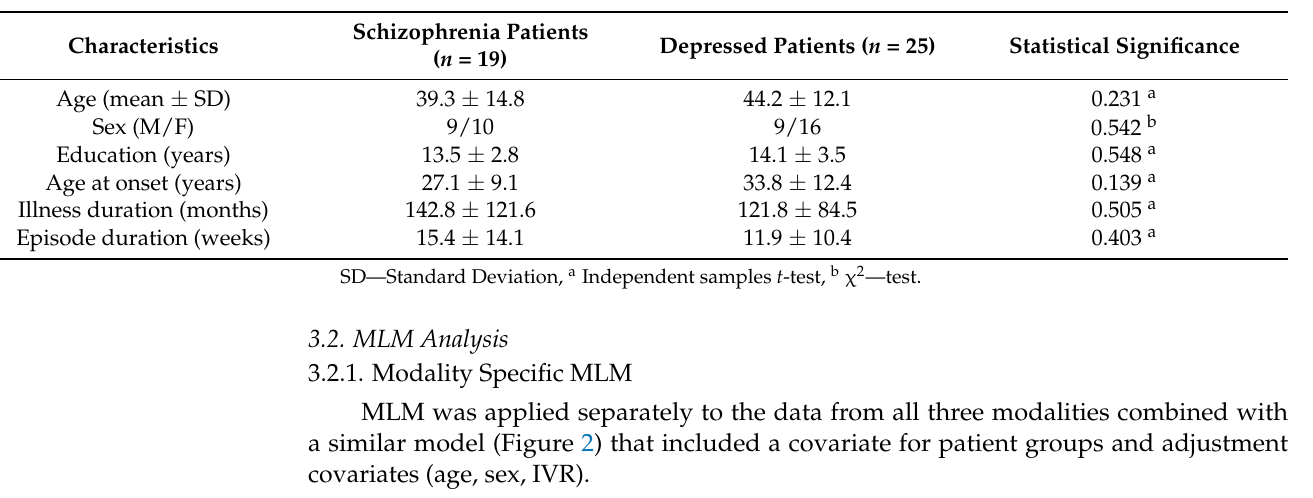
Figure 2. MLM components and subjects score for each of the modality. The first subjects, to the left (x-axis = N of subjects) correspond to the schizophrenia group and the rest to the depression group. The blue lines correspond to the calculated empirical components and the red dashed lines correspond to its projections/prediction in the space defined by the condition of interest, i.e., the differences between the two diagnostic groups. First segment of the figure shows the specific com- ponents identified using the resting state fMRI data, second segment shows the eigen-components which best summarize the fMRI task-related data; last segment shows the specific components for the anatomical differences between the two patient groups. 3.2.2. MLM analyses across the modalities: For this analysis, we used the electronic images from the first stage as input. Note that the subject loads can be used instead, and the results will remain the same (the reason is that subject spaces and the picture space are doubled, i.e., one space can be derived from